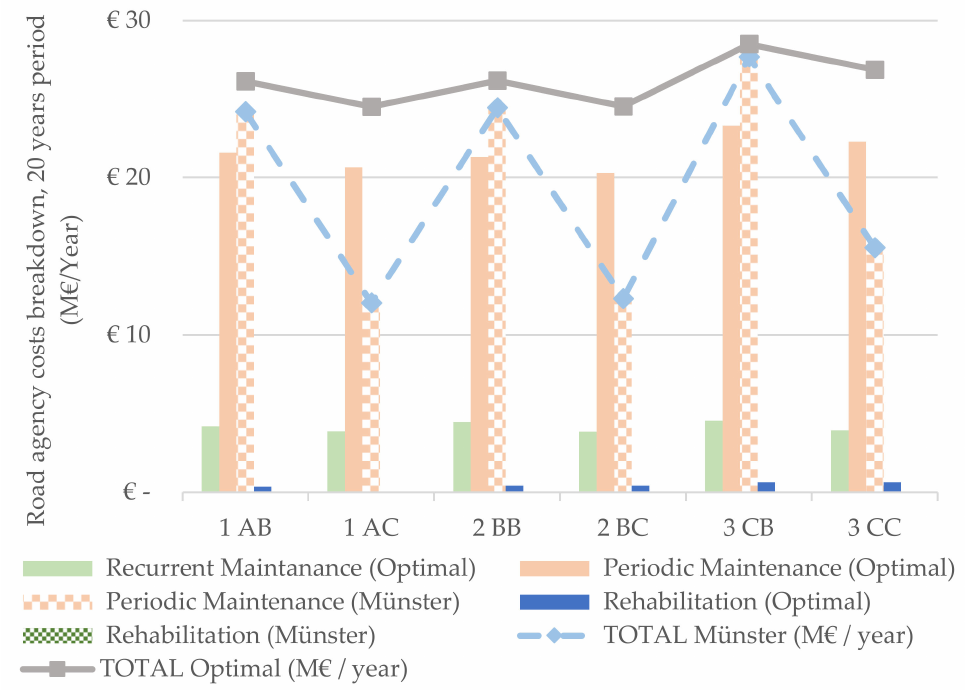
Figure 7. Comparison between the real costs invested in Munster and the ‘Optimal’ budget suggested by